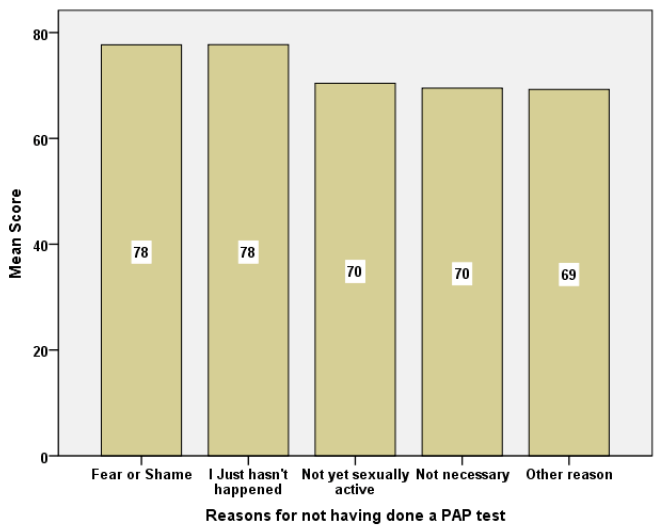
Figure 3. Barchart of social capital mean scores in relation to reasons for not having done a PAP test. Examining the group of students who had never had a PAP test due to fear/shame in relation to the rest of the groups, we found a statistical significance in the overall social